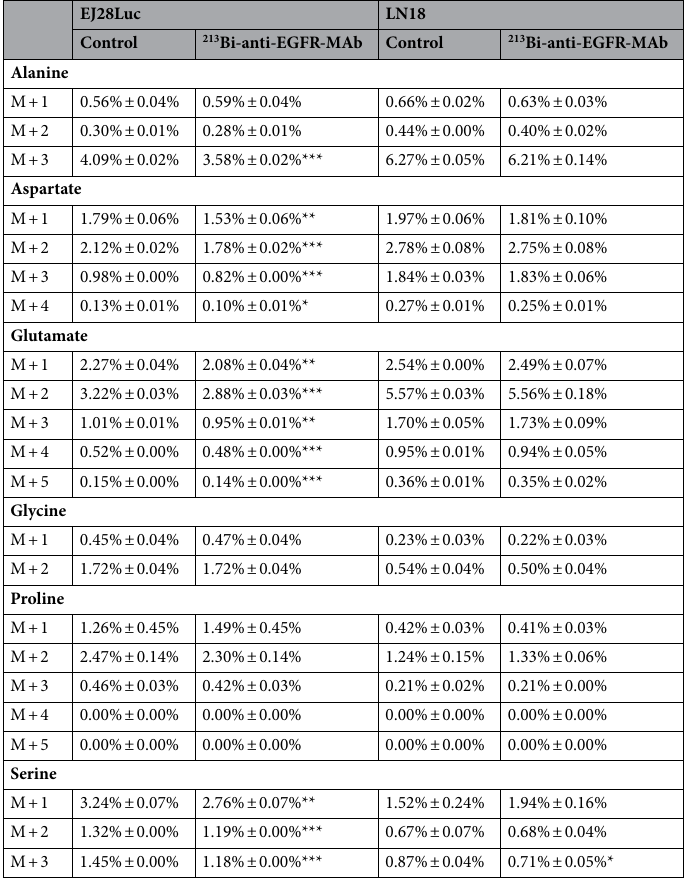
Table 1. Percentage of 13 C-enrichment and enrichment profiles in selected amino acids in controls and EJ28Luc and LN18 cell lines after treatment with 213 Bi-anti-EGFR-MAb. *p < 0.05, **p < 0.01, ***p < 0.0001 compared to